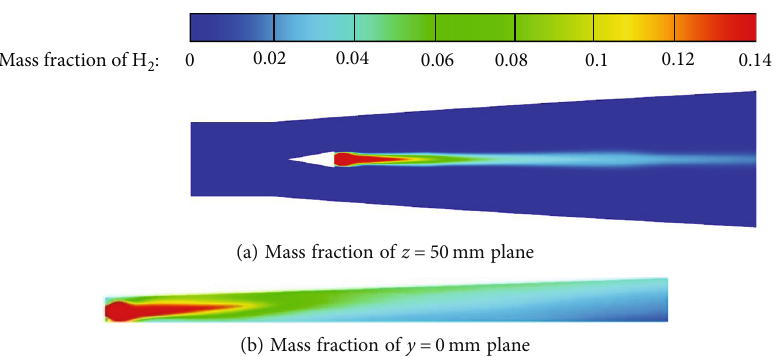
Figure 15: Distribution of mass fraction of H